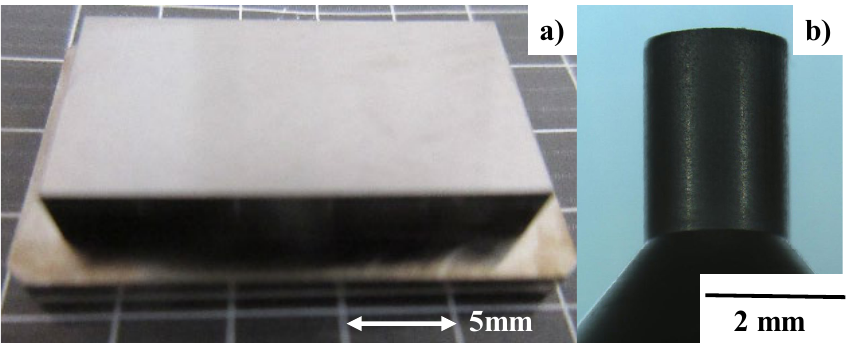
Figure 6. Plasma-nitrided SKD11 punches at 673 K for 14.4 ks. ( a ) Flat punch for CNC imprinting, and ( b ) cylindrical punch for piercing with nano-texturing.